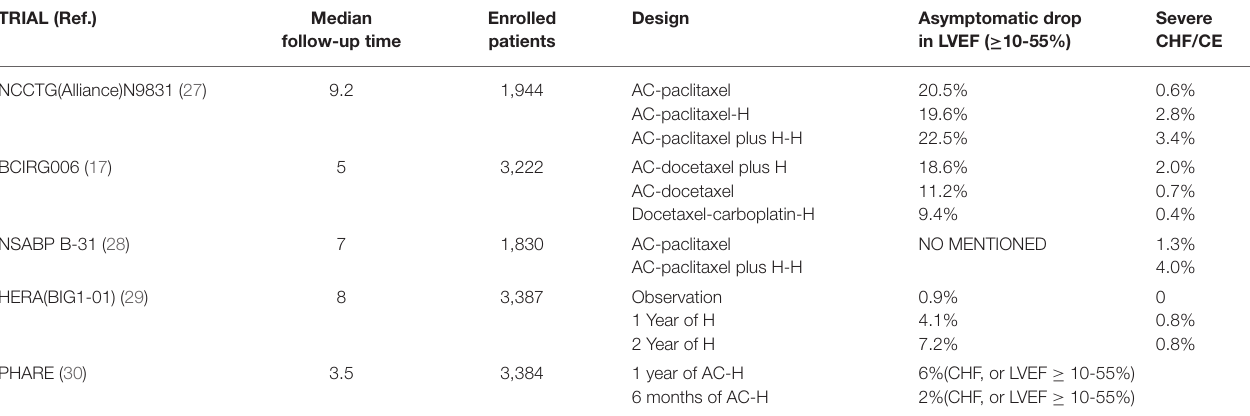
TABLE 1 | Cardiac toxicity induced by trastuzumab. TRIAL (Ref.)